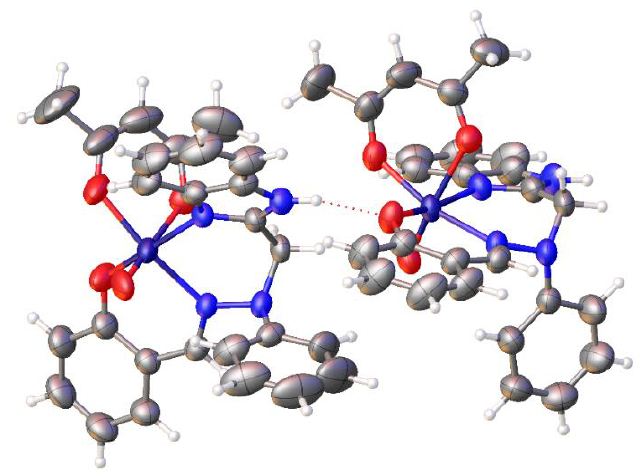
Figure 5. Asymmetric unit of compound 1 showing two molecules of the complex.